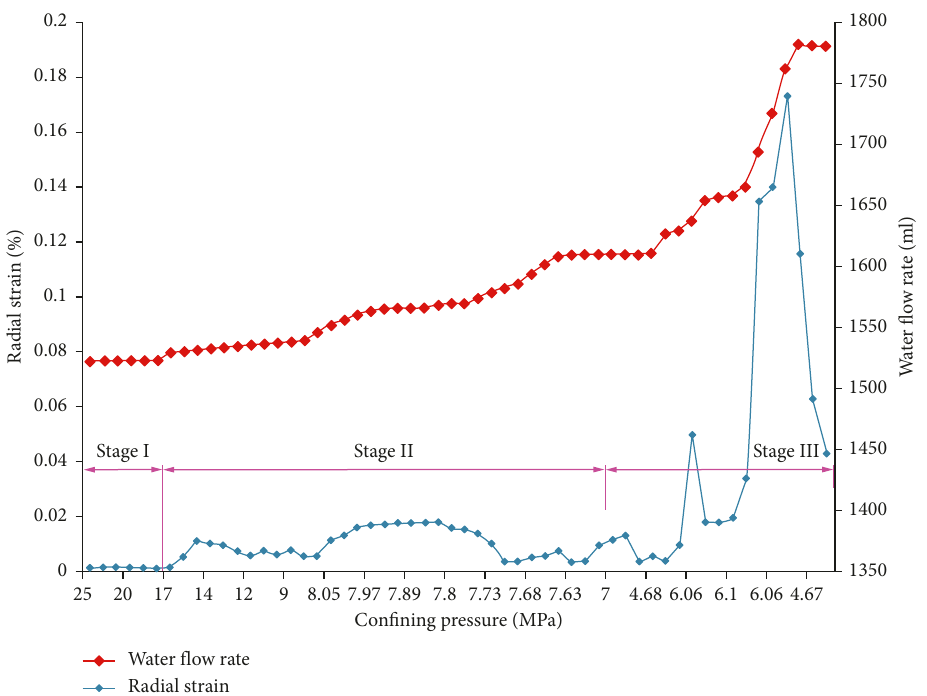
Figure 8: Changes of water flow rate and radial strain of type I rock sample with declining confining